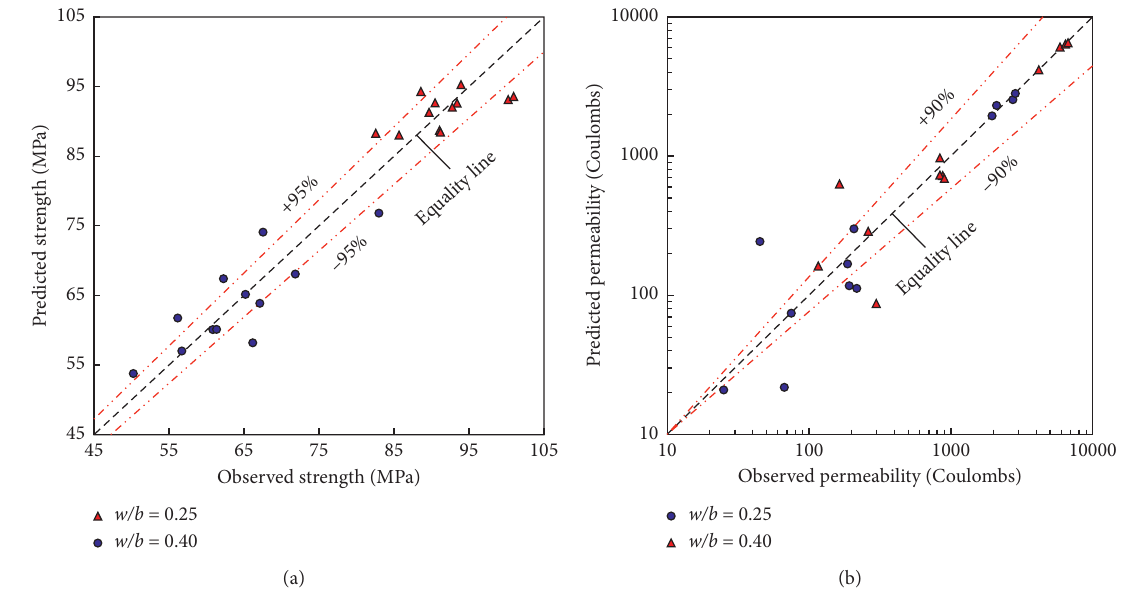
Figure 6: Predicted versus observed isoresponse (RSD). (a) Compressive strength. (b) Table 5: Paired t- and two-sample tests for the predicted and observed results. Regression method